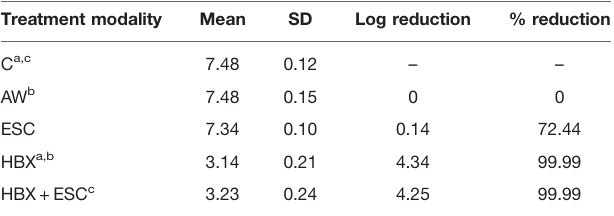
( Figure 3H,I , red boxes). In one specimen, no cell was visible ( Figure 3G ). In groups HBX, HBX + ESC, and NC, cells were more densely packed on the implant surface ( Figure 3K – R , TABLE 1 | Mean, standard deviation, logarithmic, and percentage reduction compared to group C of total viable log 10 CFU/mL in the fi ve treatment